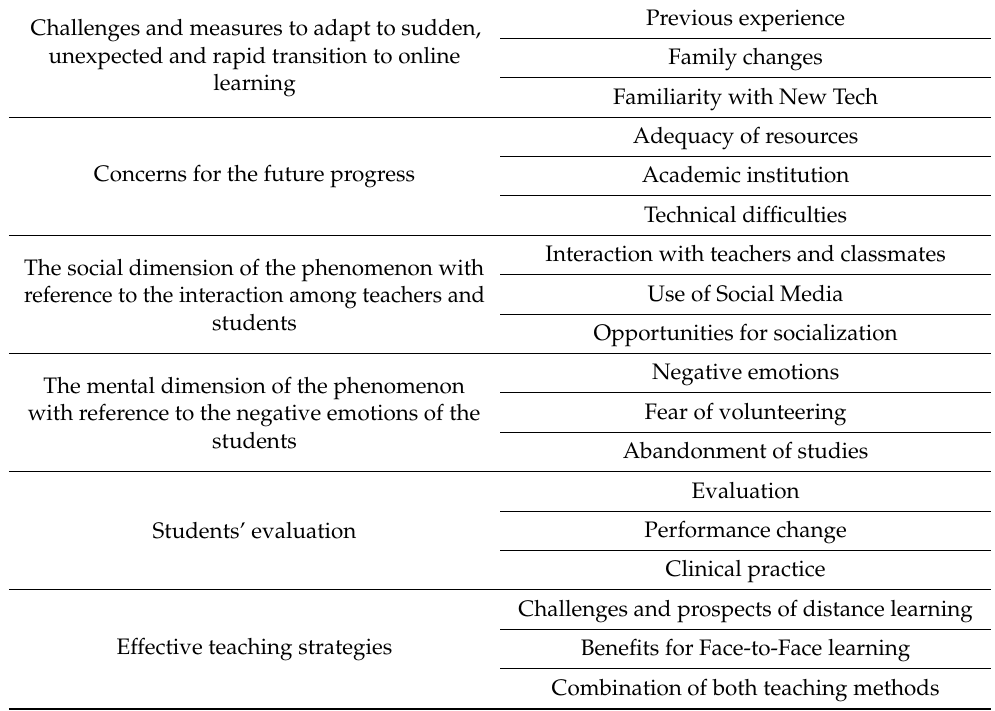
Table 1. Thematic map—sections and